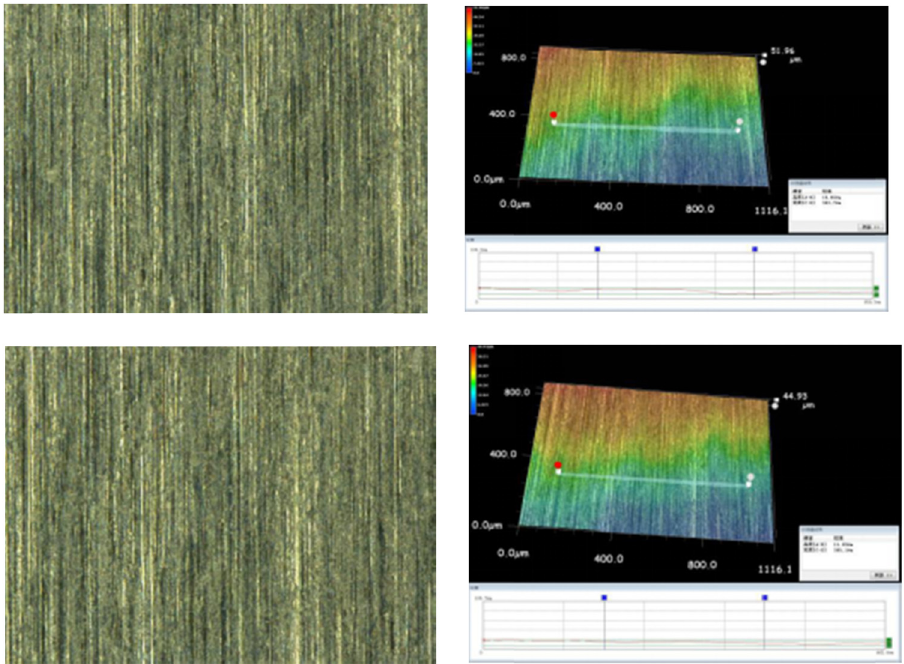
Figure 10: Grinding morphology of sample before grinding wheel